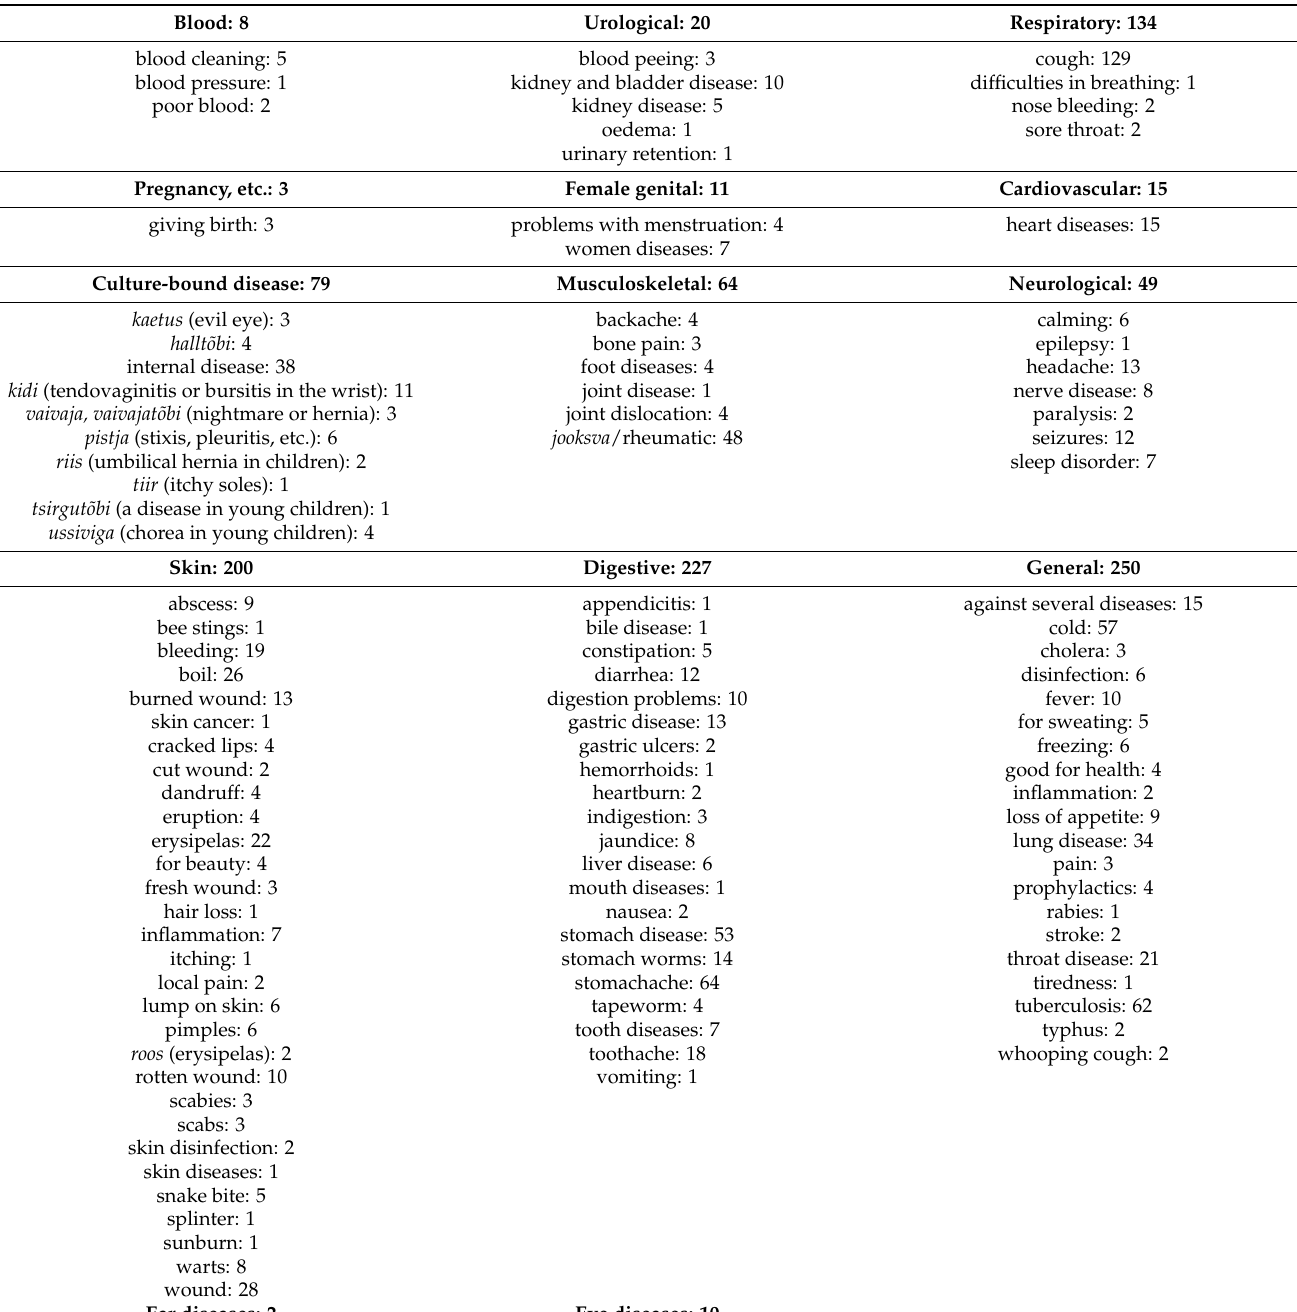
Table 1. The relationship between emic and etic disease categories and the number of UR. Bold text corresponds to etic disease categories and their summary count. Etic/emic categories: No. of